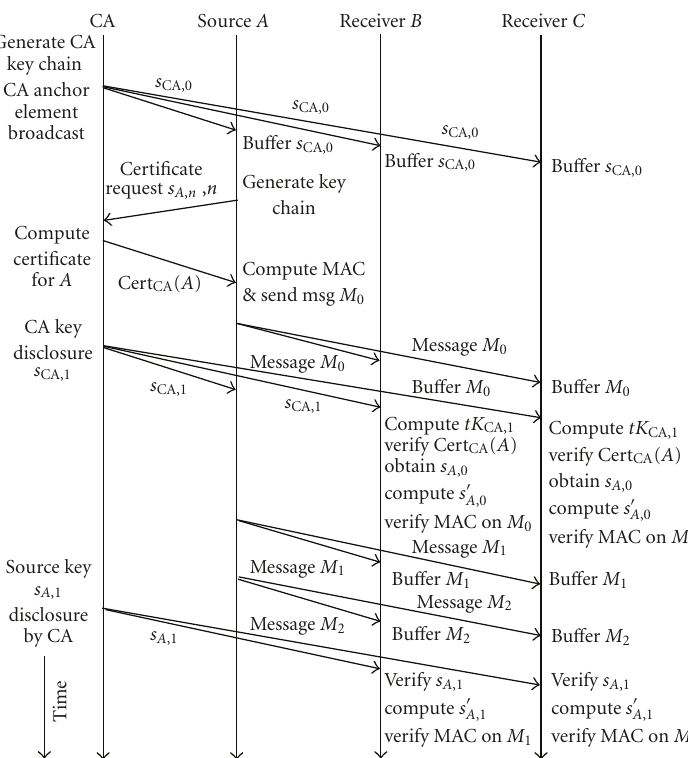
Figure 3: Time diagram for source authentication using the extended TESLA